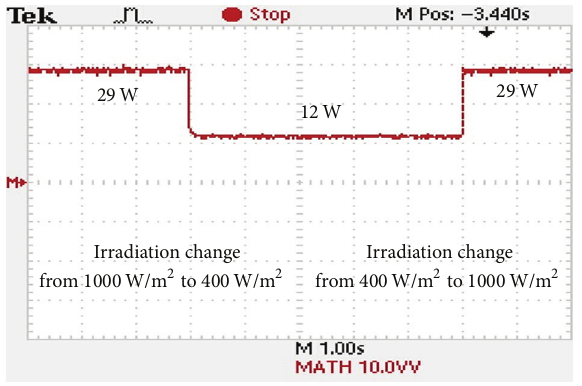
Figure 17: Experimental results for SMESC performance given step change in irradiance from 1000W/m 2 to 400W/m 2 followed by step change from 400 W/m 2 to 1000W/m 2 .